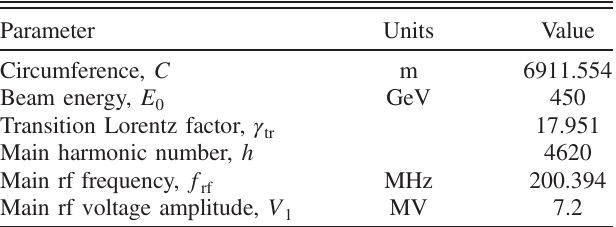
TABLE I. The SPS parameters at the flattop energy [30].